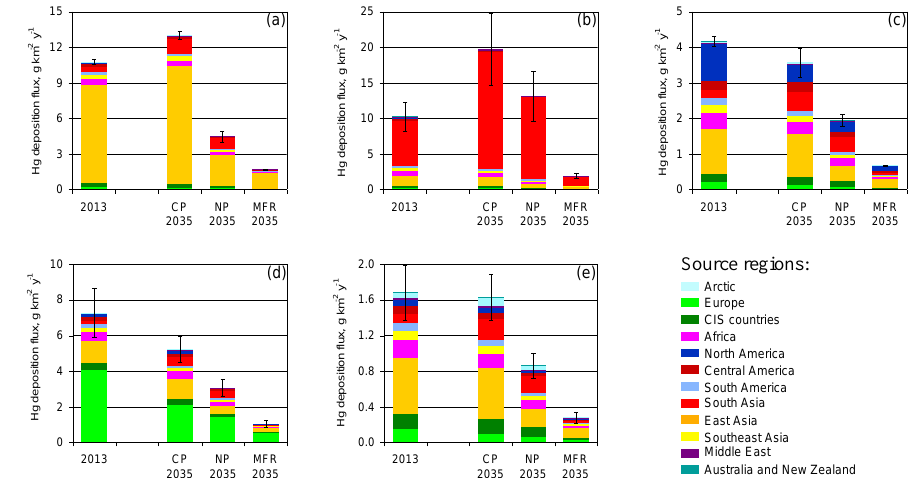
Figure 11. Source apportionment of mercury deposition from direct anthropogenic sources (average of two models) in 2013 and 2035 in various geographical regions: (a) East Asia, (b) South America, (c) North America, (d) Europe, (e) , and the Arctic. Whiskers show deviation between the models. Note different scales of the diagrams for different regions.